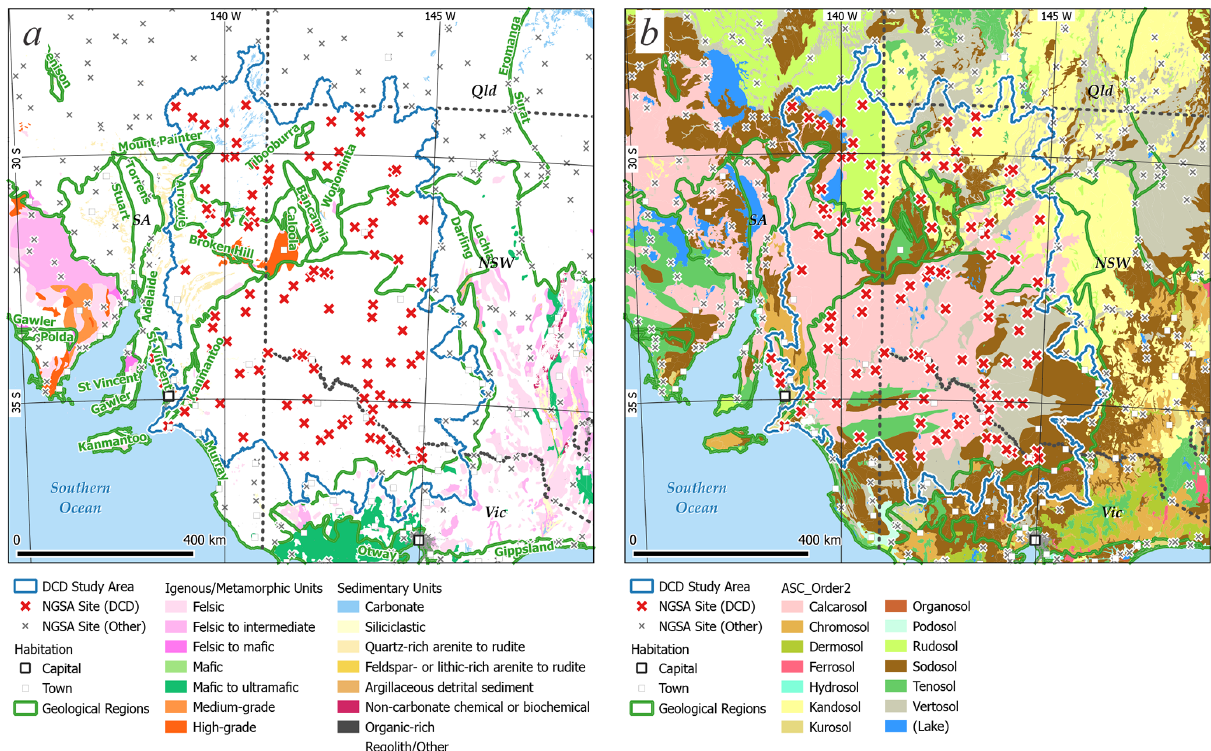
Figure 2. The Darling–Curnamona–Delamerian (DCD) Sr isotope study area (dark blue outline), National Geochemical Survey of Australia (NGSA) sample locations (crosses), and geological regions (double green outlines) from Blake and Kilgour (1998) overlain on (a) surface geology from Raymond et al. (2012); and (b) Australian Soil Classification soil orders from Isbell and the National Committee on Soil and Terrain (2021). Map projection: Albers equal